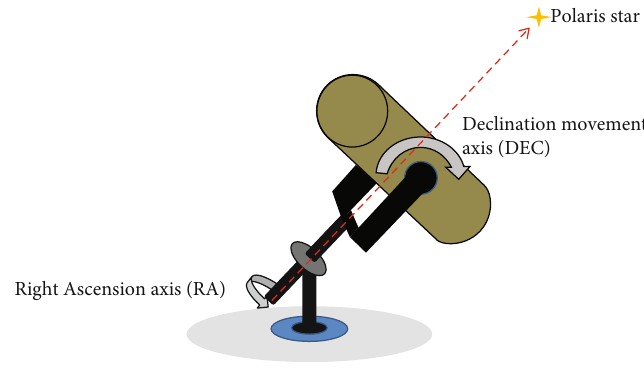
Figure 2: The telescope on an equatorial mount.